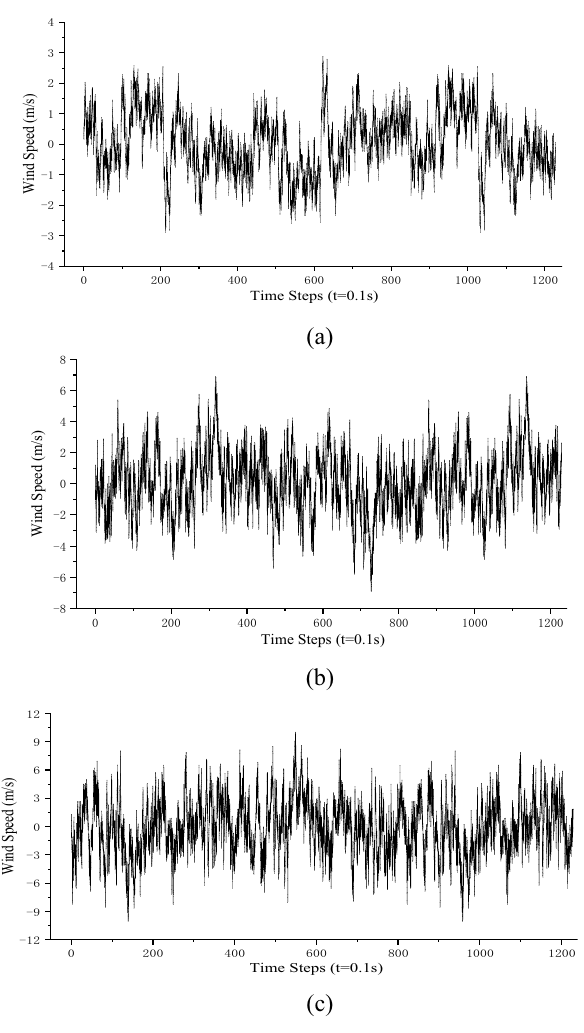
Fig. 5 Fluctuating wind time-history curve of STM. a speed =5 m/s; b speed =10 m/s; c speed =15 m/s